Question: According to this chart, does the measure grow or shrink?
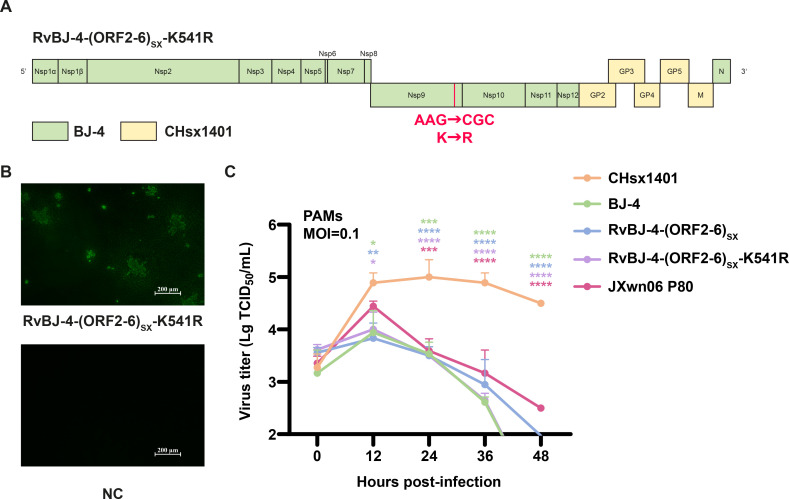
Answer: increasing